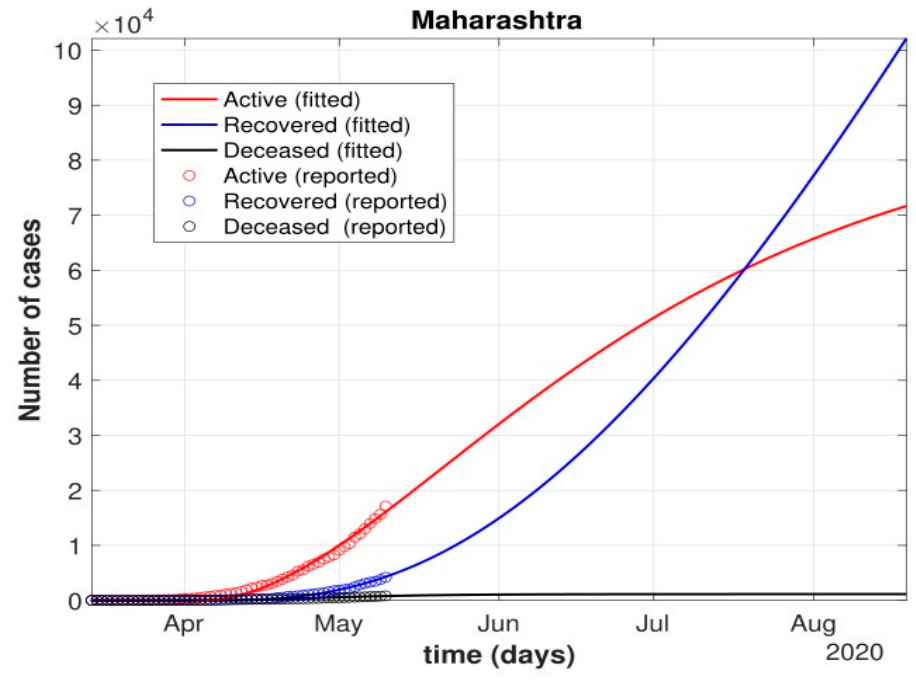
Figure 13. Prediction of the number of cases in Maharashtra using the proposed model.